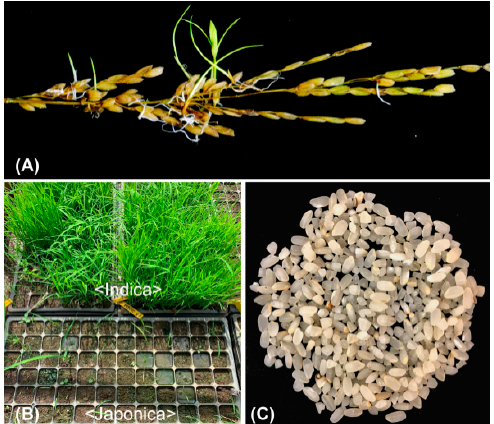
Figure 2. Inferior grain quality of temperate japonica rice under the tropical climate. ( A ) Pre-harvest sprouting, ( B ) short seed longevity, and ( C ) cracked milled rice.